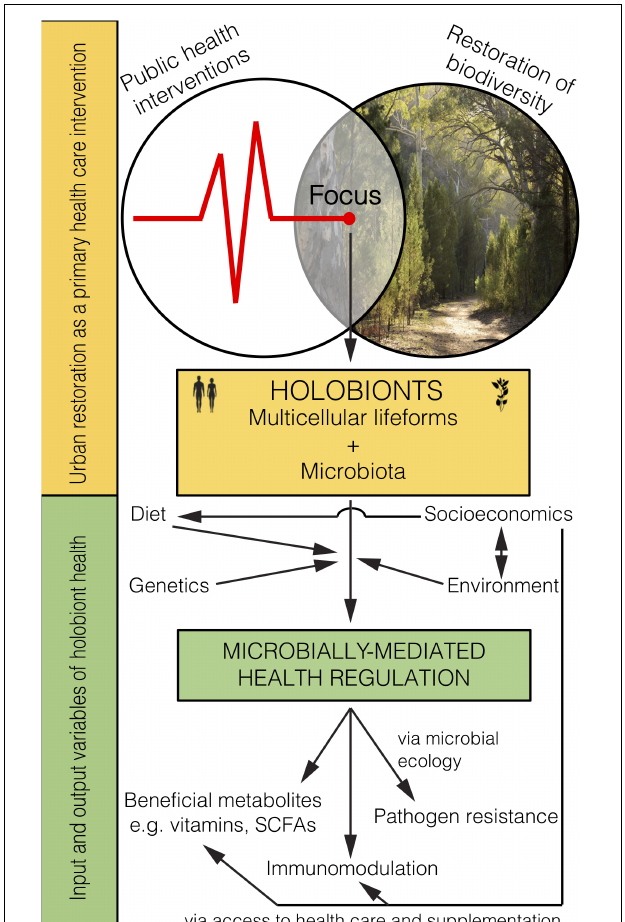
FIGURE 2 | Microbiome rewilding via the restoration of biodiversity to urban habitats holds great potential as an environmental input to microbially-mediated health regulation of holobionts, including humans, as a primary health intervention that transcends socioeconomic status.